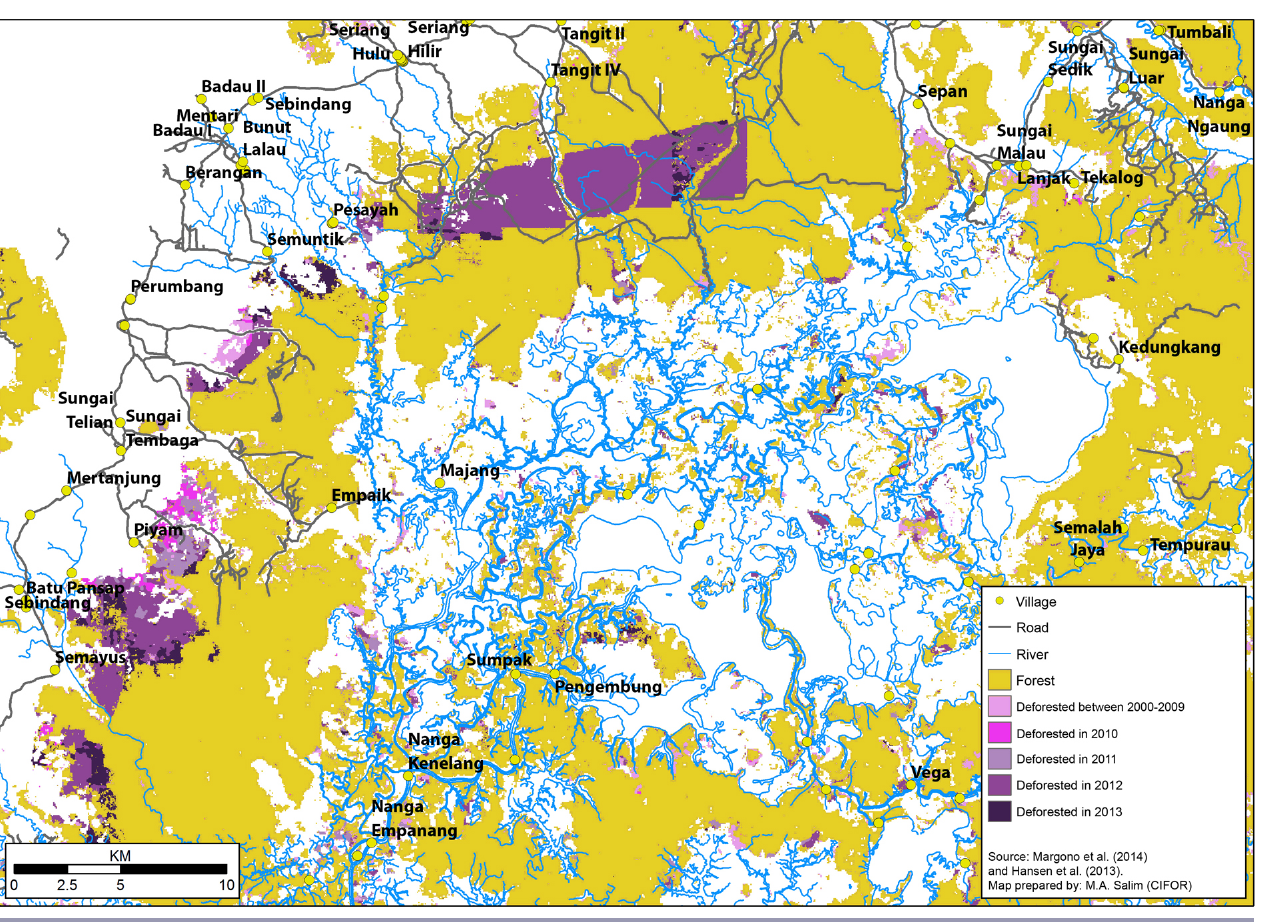
Fig. 1 . Deforestation between 2001 and 2014 in the northwestern part of Kapuas Hulu district. Map by: M. A. Salim, CIFOR. Source of data: Hansen et al. 2013, Margono et al.